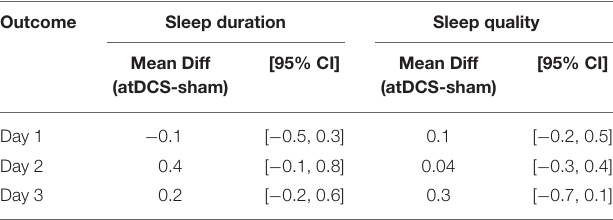
TABLE 4 | Mean difference (Mean Diff) and 95% CI of model based post-hoc comparisons (mixed model analysis between atDCS and sham (atDCS-sham); n = 31 individuals in training with atDCS sessions, n = 30 individuals in training with sham session; data points in total 187*) for reported sleep duration and sleep